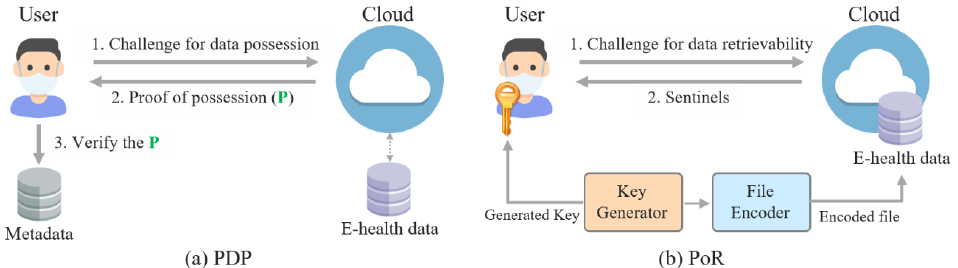
Figure 10. Overview of PDP and